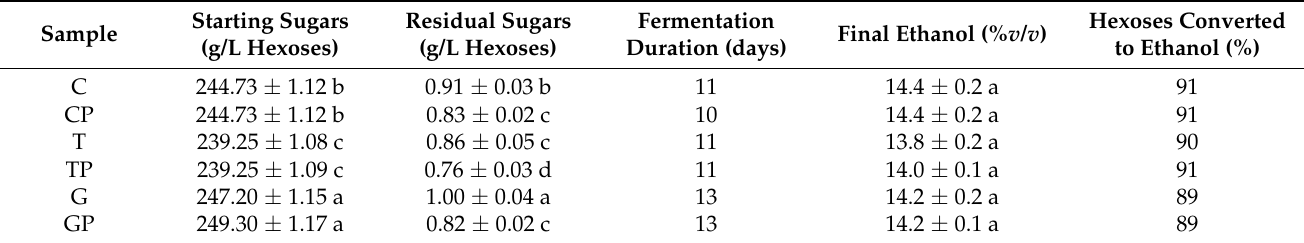
Table 3. Values of starting sugars, residual sugars, the duration of fermentation (days), the fi- nal ethanol produced, and the % of hexoses converted into ethanol. C = Castellina, G = Gaiole,